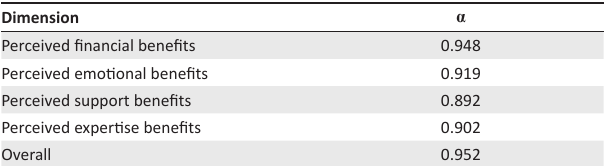
TABLE 5: Reliability results.